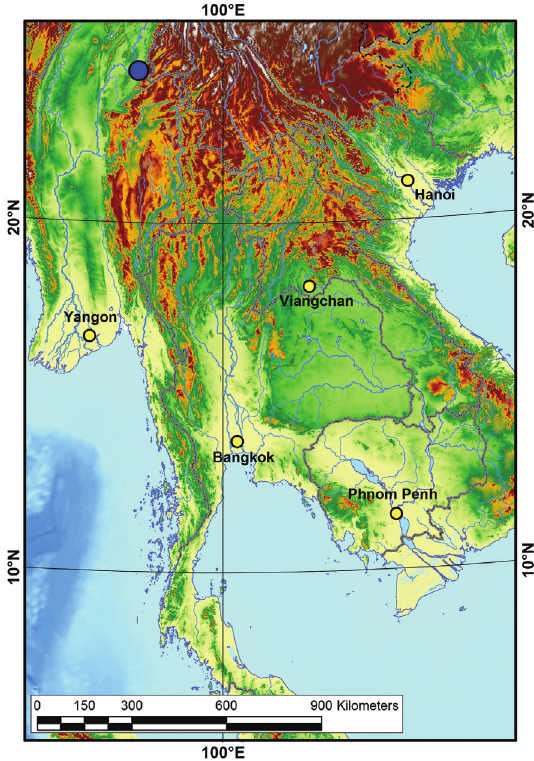
Figure 3. Map of the type locality of Indonaia rectangularis (Tapparone-Canefri, 1889), comb. nov. (dark blue circle). The digital elevation model and other layers of the map were added from the Esri Data & Maps 10